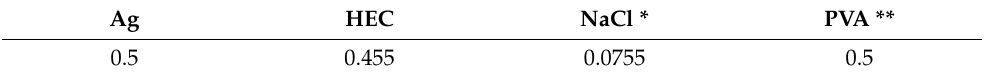
Figure 8. SEM-EDX analysis on particle deposited on filter. Table 3. Composition (% w / w ) of aqueous Ag-based coating sprayed on polyester textile